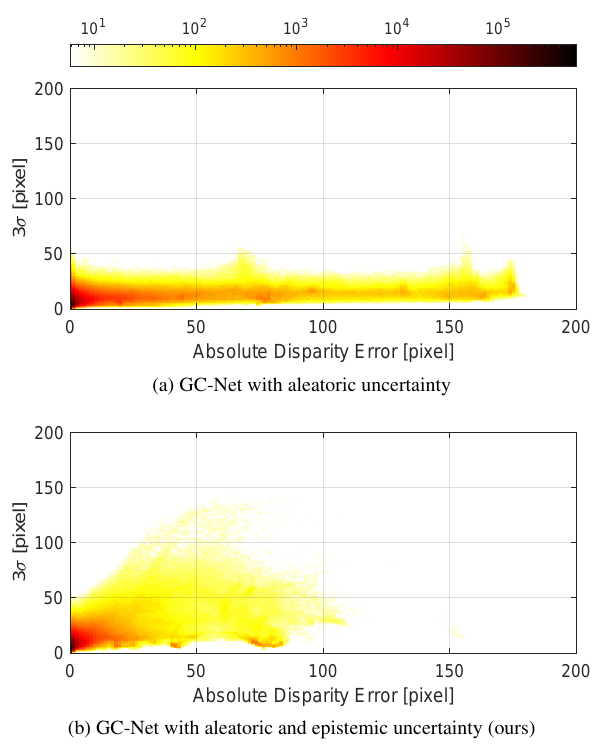
Figure 4: Absolute error uncertainty relation on all images of the Middlebury dataset. The logarithmic colour scale encodes the number of pixels having the respective error and estimated standard deviation σ . In case of optimal uncertainty estimation, all pixels would be located close to the diagonal, showing an in- creasing uncertainty with increasing